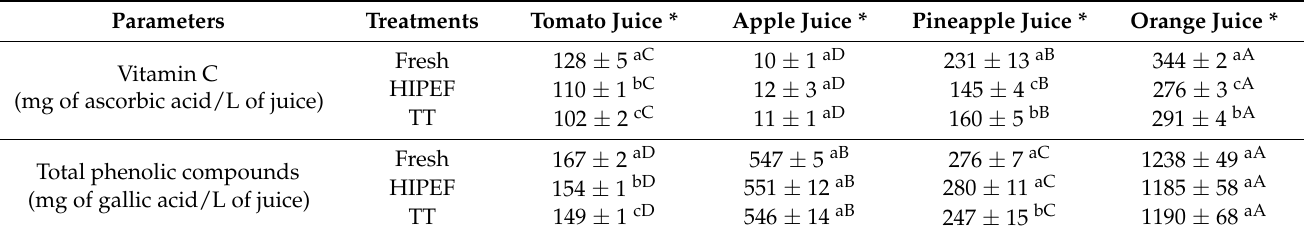
* Data shown are mean ± standard deviation ( n = 6). Different lower case letters in the same column for each parameter indicate significant differences among treatments ( p < 0.05) for each juice. Different capital letters in the same row indicate significant differences among juices for the same